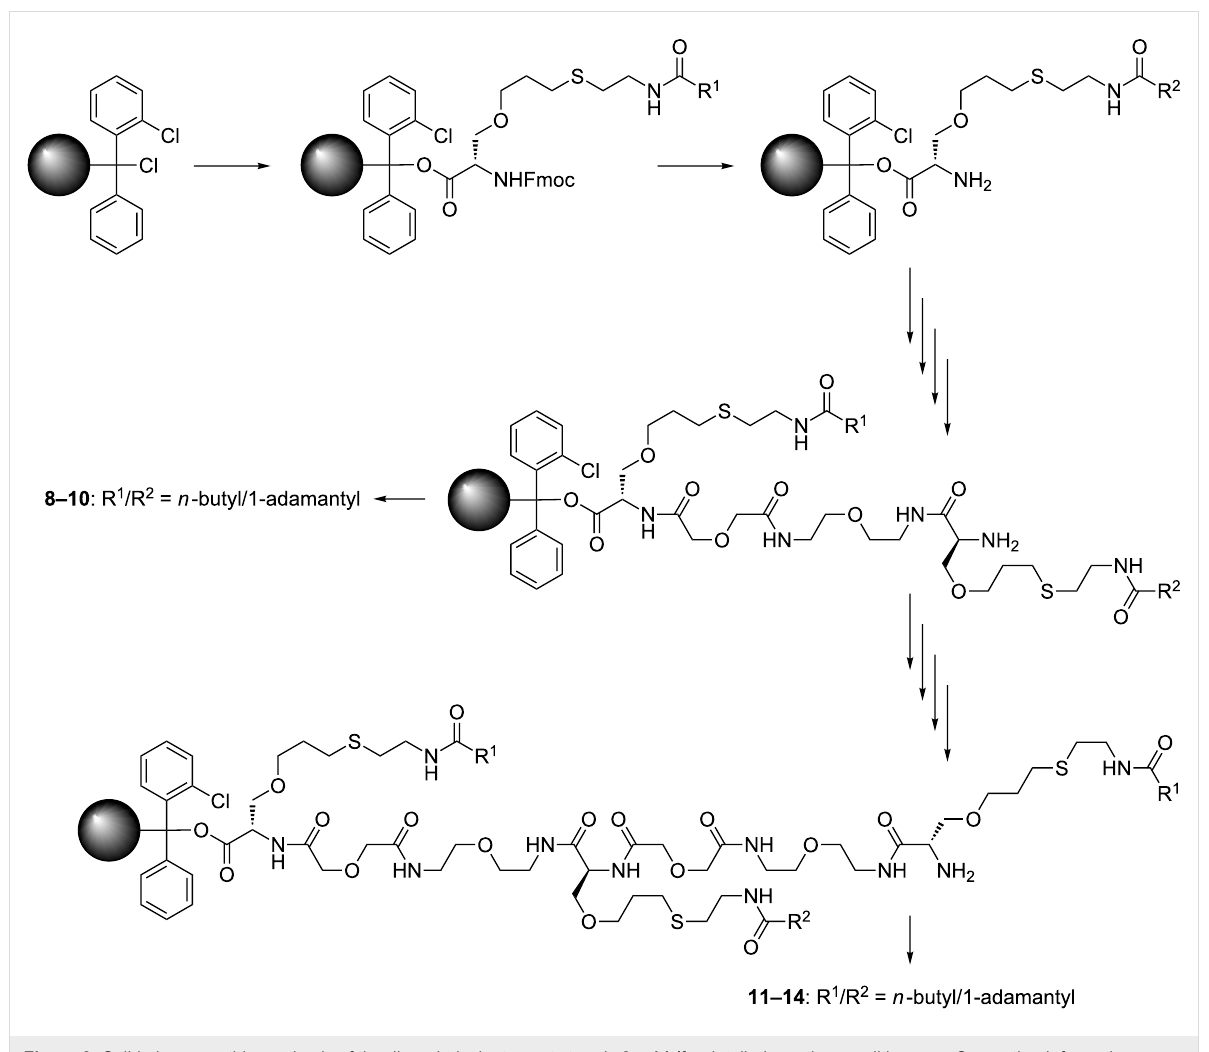
Figure 3: Solid phase peptide synthesis of the di- and trivalent guest strands 8 – 14 ( for detailed reaction conditions see Supporting Information File 1).